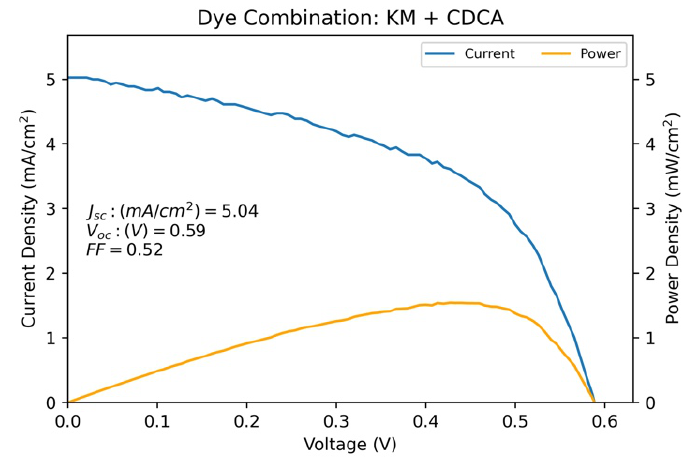
Figure 11. KM co-adsorbed with 1:1 CDCA.